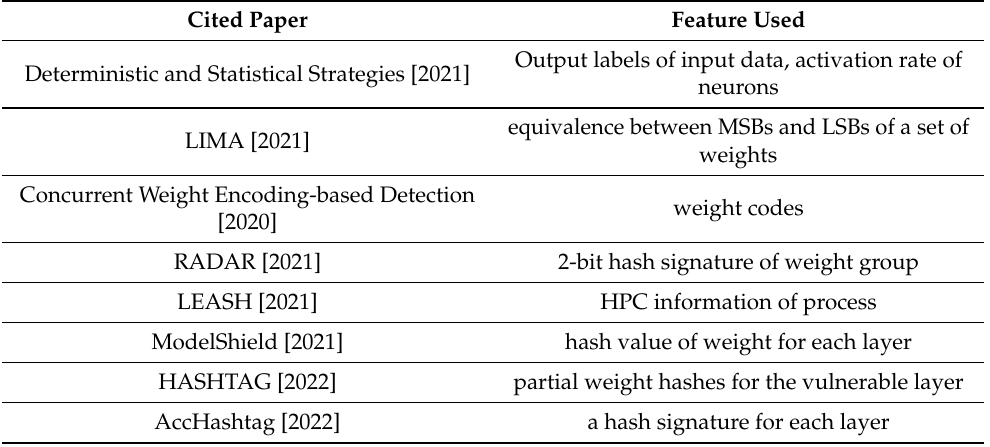
Table 9. Factors used to detect